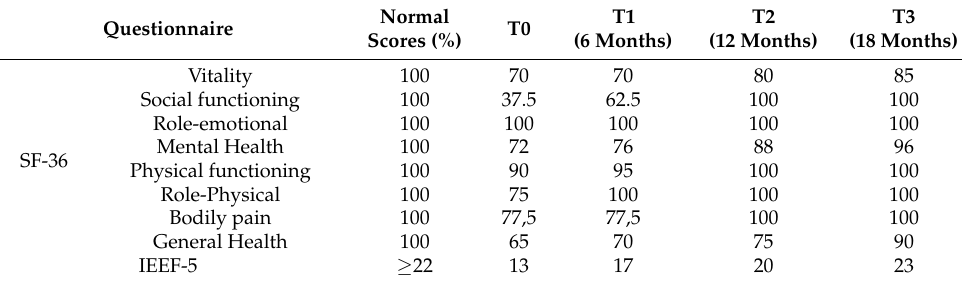
Table 3. Questionnaires scores during follow-up period.